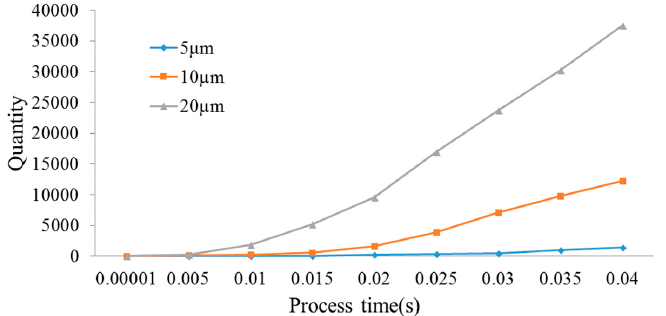
Figure 13. The quantity variation of debris.